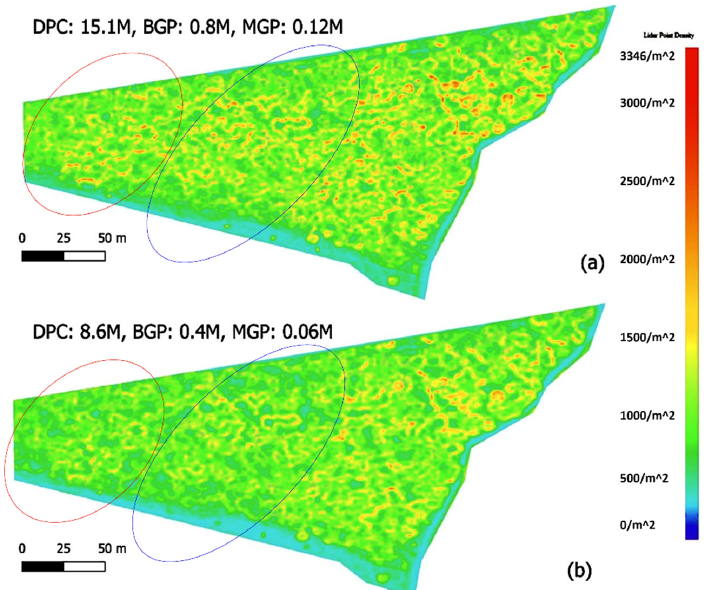
Figure 8. Distribution of the DPC when applying the ( a ) TAF and ( b ) NTAF. The difference in DPC ground point numbers in millions (M), bottom-area (red circle) ground points (BGPs), and middle-area (blue circle) ground points (MGPs) was significant when using the ( a ) TAF and ( b ) NTAF. Table 1. Treetop detection validation: Results of the matching percentage and repeated percentage. This table shows the results of the two algorithms when using the TAF and NTAF, following three crown-radius parameters.